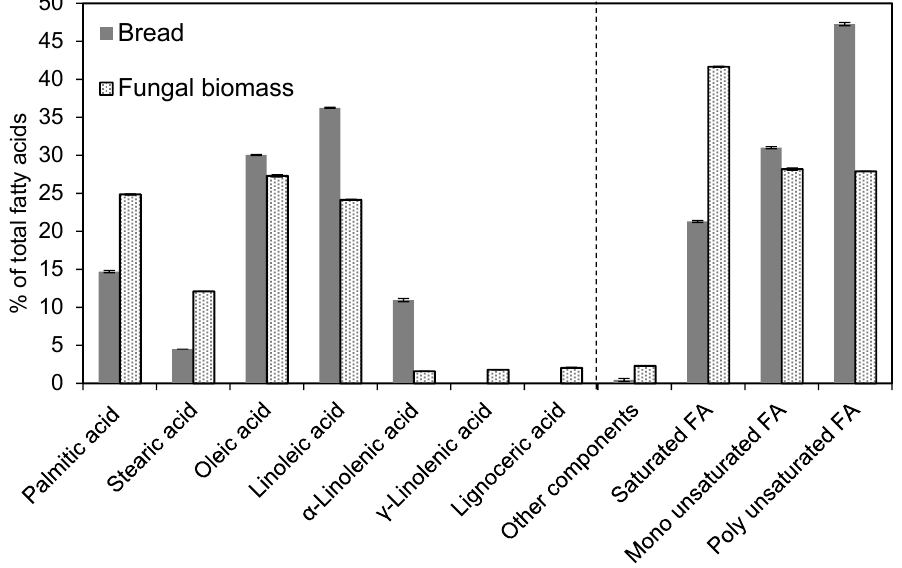
Figure 7. Fatty acid profiles. FA stands for fatty acid. Fatty acids with concentrations of <1% were omitted. The error bars represent ± one standard deviation.